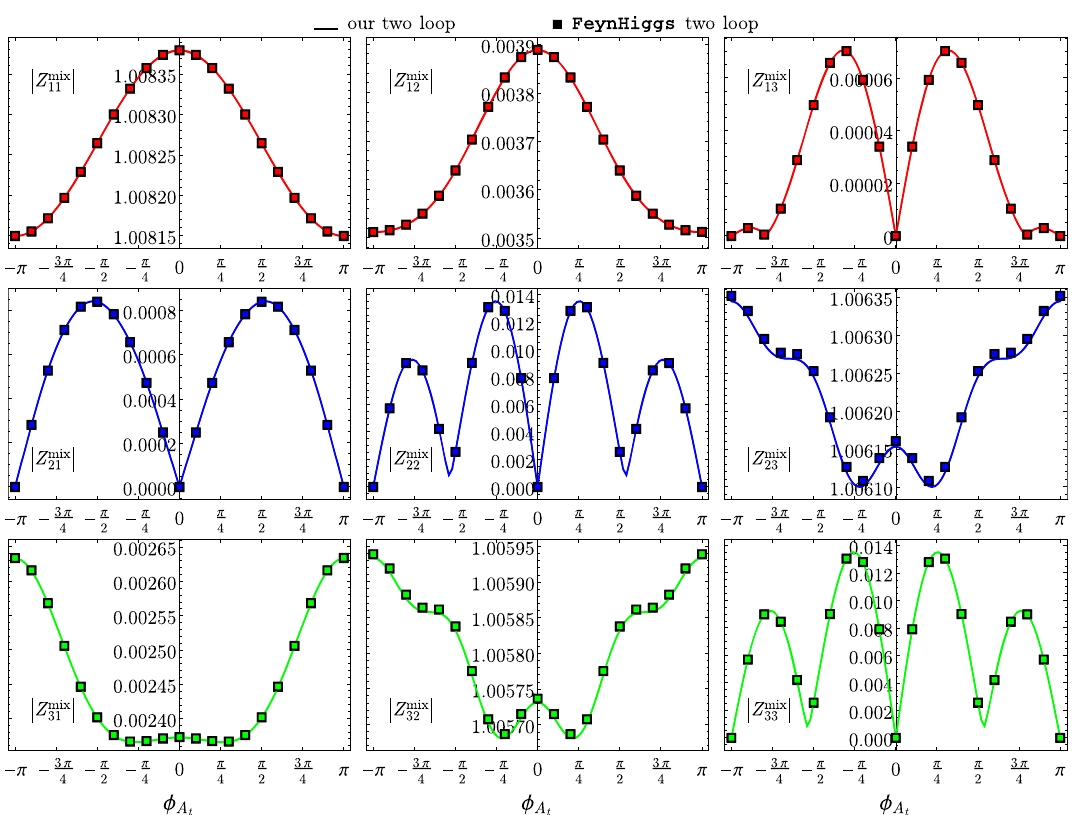
Fig. 2 Modules for the nine elements of the matrix Z mix , obtained with our calculation ( solid line ) and FeynHiggs ( squares ). The col- ors follow the convention of Fig. 1: red for the coefficients defining the